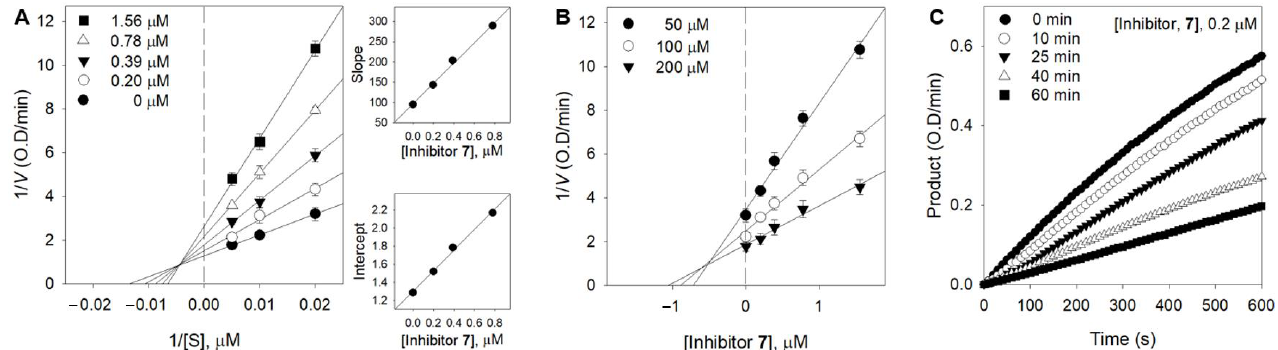
Figure 3. Enzymatic kinetics of XO inhibition by 7 . ( A ) Lineweaver–Burk plots of 7 . (Inset) The secondary plots of the slope and the intercept of the straight lines versus the concentration of 3 throughout Equations (1)–(3) are shown. ( B ) Dixon plots of 7 . The graphical symbols are substrate concentrations (50 µ M, • ; 100 µ M, ; 200 µ M, (cid:72) ). ( C ) Inhibition as a function of preincubation time (cid:35) for 7 at 0.2 µ